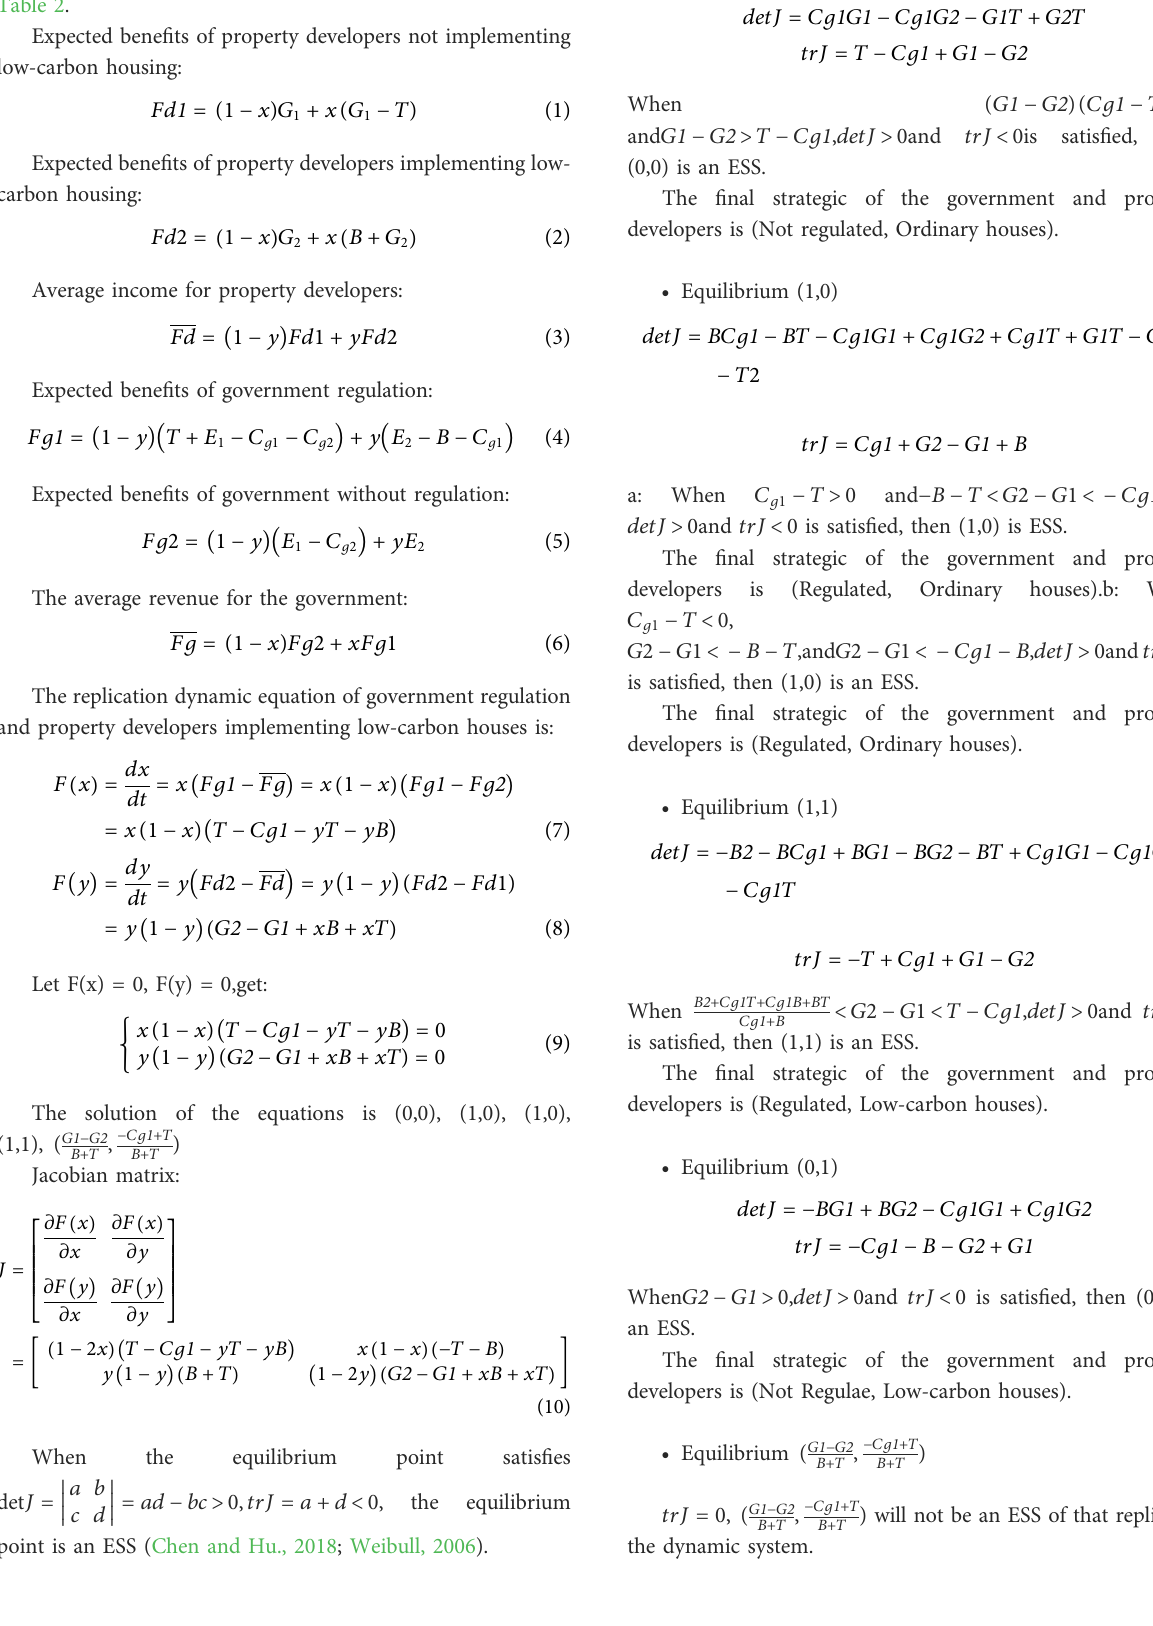
levied on ordinary houses. The game pay-off matrix is shown in Table 2. Expected bene fi ts of property developers not implementing low-carbon housing: